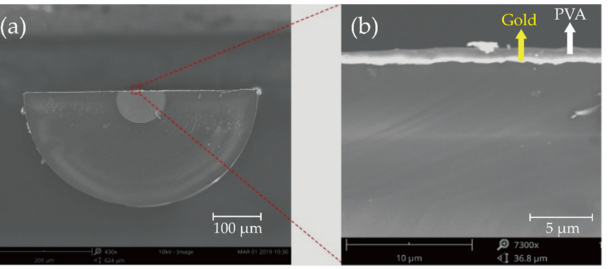
Figure 3. ( a ) SEM image of the PVA-coated RH sensor in cross-sectional view. ( b ) Enlarged view of the red area marked in ( a